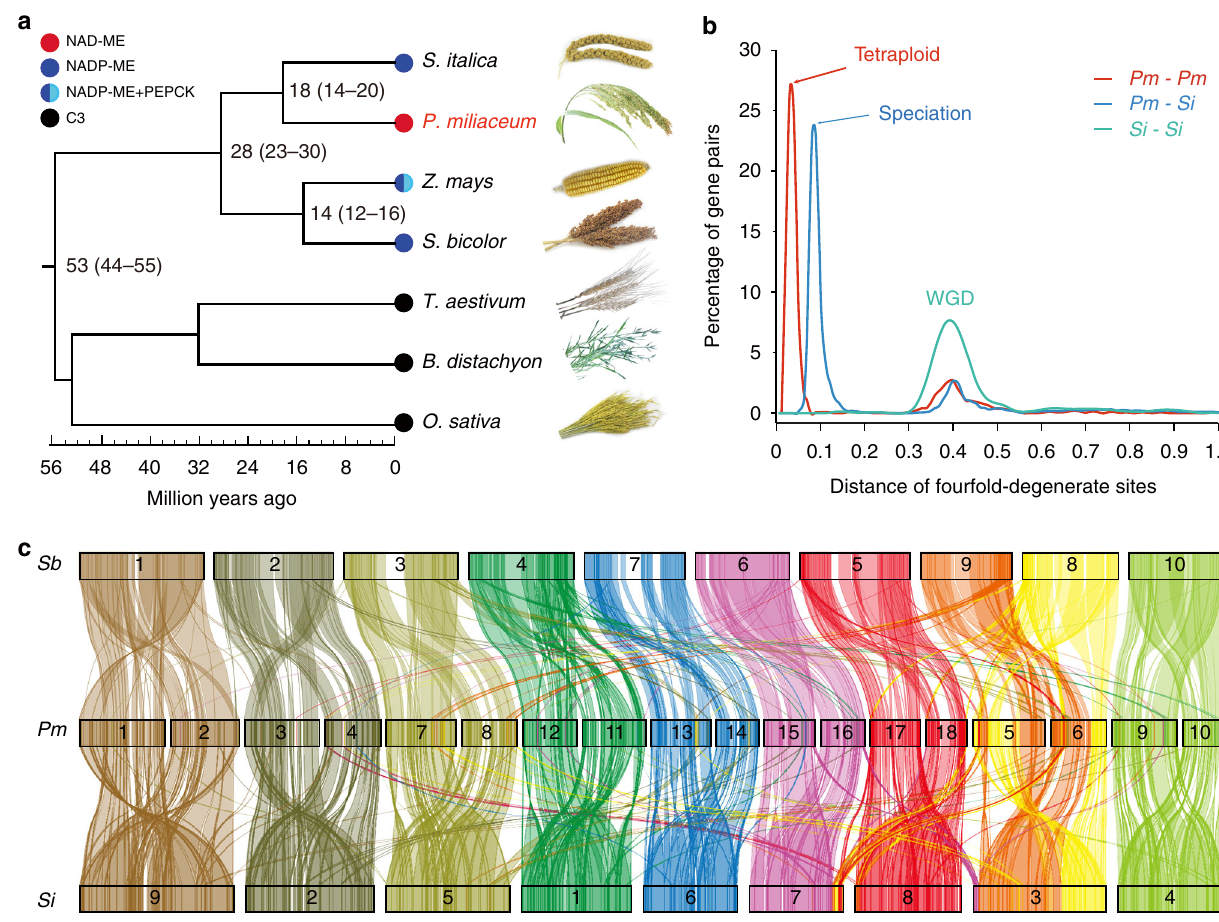
Fig. 2 Evolutionary analyses of the broomcorn millet genome. a Species phylogenetic tree constructed from single-copy orthologs. Lineage divergence time is indicated at each branch point. The photosynthesis type of each species is indicated by colored dots at each node. b 4DTv distance of homologs genes from broomcorn millet ( Pm ) and foxtail millet ( Si ). c Synteny blocks identi fi ed between broomcorn millet and foxtail millet, and between broomcorn millet and sorghum ( Sb ). Only synteny blocks >0.5 Mb long are